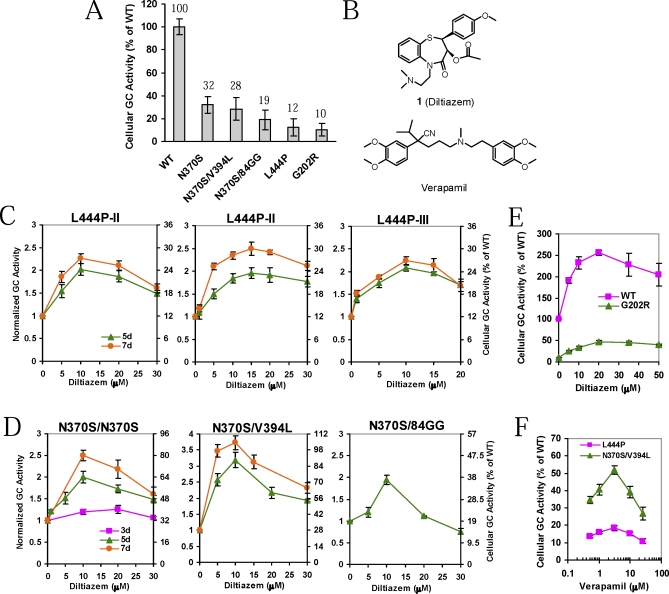
Influence of Small Molecules on GC Variant Activity in Gaucher Patient-Derived Fibroblasts(A) Residual activities of GC variants using the lysed cell GC activity assay, using equal numbers of cells as ascertained from the equal total protein content of the lysate. Residual activities of N370S, N370S/V394L, N370S/84GG, L444P, and G202R GC are shown as the percentage of WT GC activity (numbers above each column).(B) Chemical structures of diltiazem (compound 1) and verapamil.(C) The influence of diltiazem (1) on L444P GC activity in three distinct homozygous L444P GC patient-derived cell lines: L444P GC fibroblasts from a type II patient (left panel), another type II patient (middle panel), and a type III patient (right panel). These cell lines were cultured with diltiazem for 5 d (green line) and 7 d (orange line). The GC activity of treated cells was normalized against that of untreated cells of the same type (left y-axis) and expressed as the percentage of WT GC activity (right y-axis).(D) The influence of diltiazem on N370S GC activity in homozygous N370S/N370S GC fibroblasts (left panel), heterozygous N370S/V394L fibroblasts (middle panel), and heterozygous N370S/84GG fibroblasts (right panel). These cell lines were cultured with diltiazem for 3 d (pink line), 5 d (green line), and 7 d (orange line). The GC activity of treated cells was normalized against that of untreated cells of the same type (left y-axis) and expressed as the percentage of WT GC activity (right y-axis).(E) The influence of diltiazem on WT and G202R GC activity. WT and G202R GC cell lines were cultured with diltiazem for 5 d. The GC activity was expressed as the percentage of WT GC activity.(F) The influence of verapamil on L444P and N370S/V394L GC activity. These cell lines were treated with verapamil for 7 d. The GC activity was expressed as the percentage of WT GC activity.